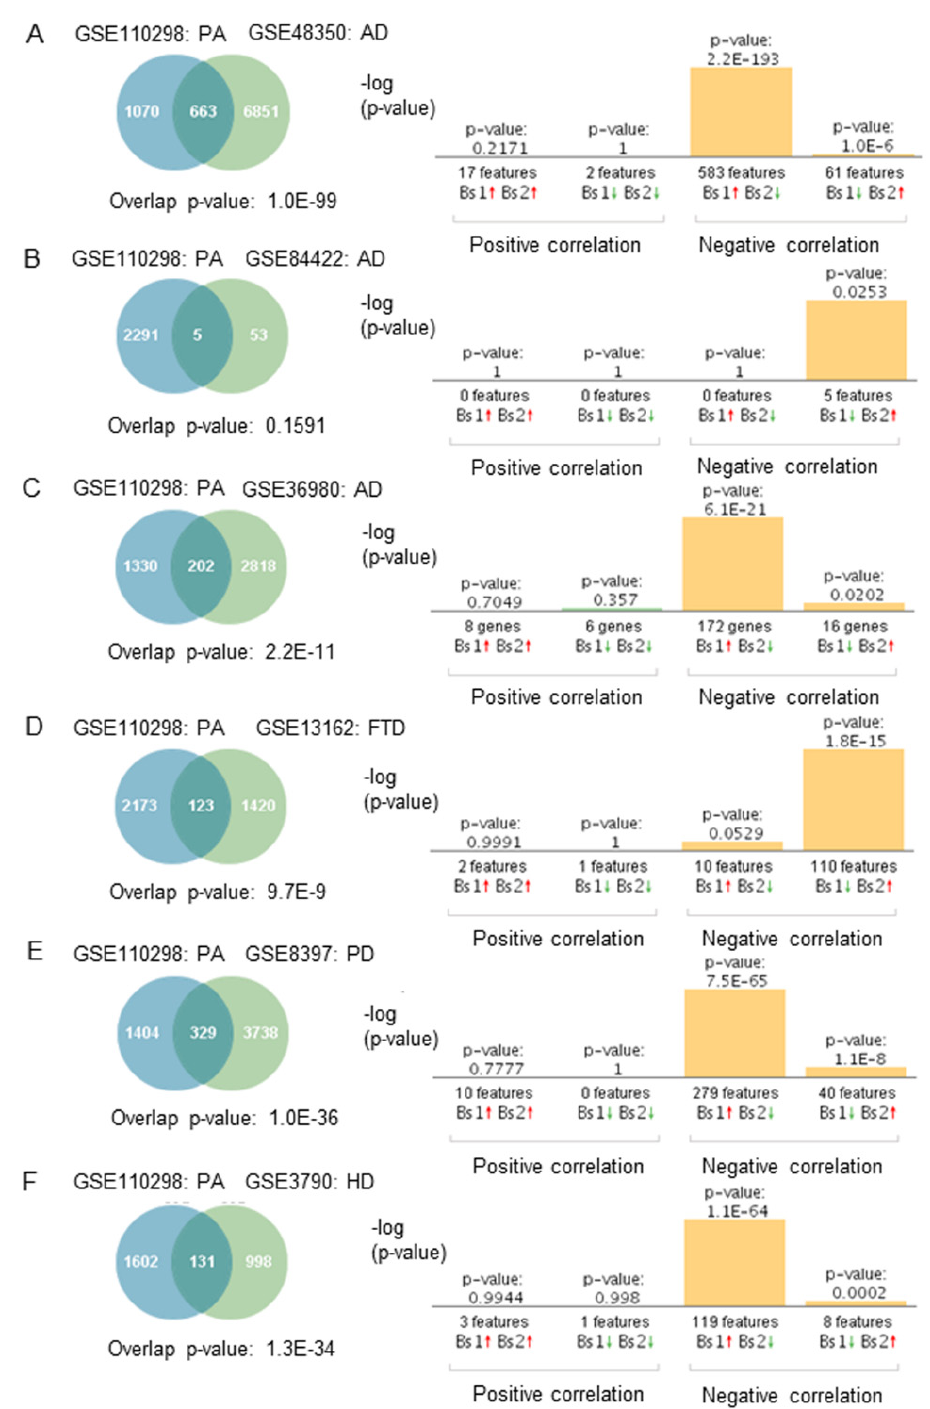
Figure 3. Genetic overlap and correlation analysis between subjects who engaged in high and moderate physical activity and patients with neurodegenerative diseases. Venn diagram and correlation analyses of shared genes between physically active (PA) subjects in GSE110298 and ( A ) AD GSE48350, ( B ) AD GSE84422, ( C ) AD GSE36980, ( D ) FTD-GRN (+) GSE13162, ( E ) PD GSE8397, ( F ) HD GSE3790. Vertical bars represent the significance of the overlap and the correlations between the datasets. Red and green arrows denote up and downregulation, respectively. p -value is expressed as the –log10 of the p -value. Statistical significances regarding the genetic overlap and the directionality of the fold changes were derived from the non-parametric ranking method used by Base Space Correlation Engine (Illumina, Inc., San Diego, CA, USA).